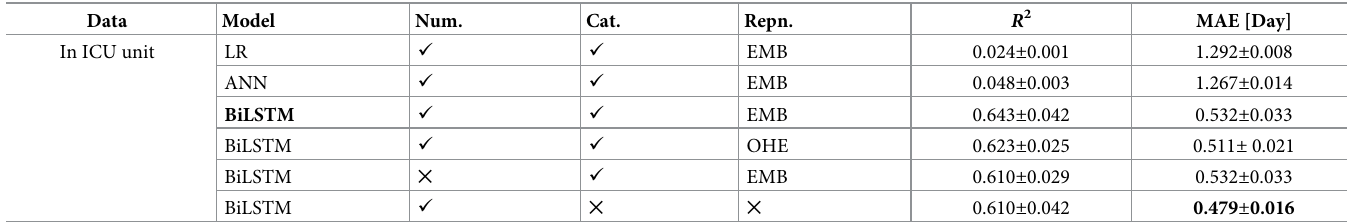
Table 6. Length of stay in hospital prediction, evaluated using Mean Absolute Error